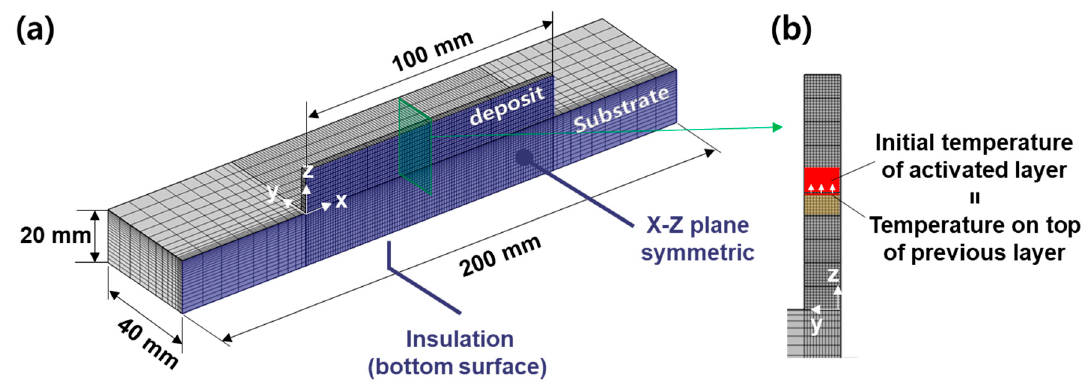
Figure 3. Finite element model for WAAM simulation: ( a ) shape of the symmetric model and ( b ) initial temperature of a new layer.